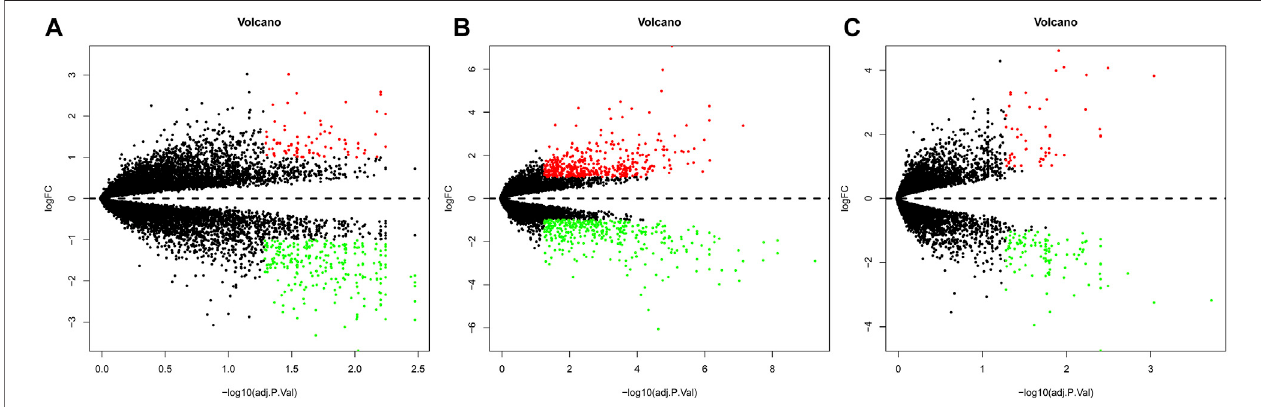
FIGURE2| VolcanoplotshowingDEGs. (A) GSE55457, (B) GSE55235,and (C) GSE1919.Reddots:upregulated genes,greendots:downregulated genes,and gray dots: genes without change in expression.